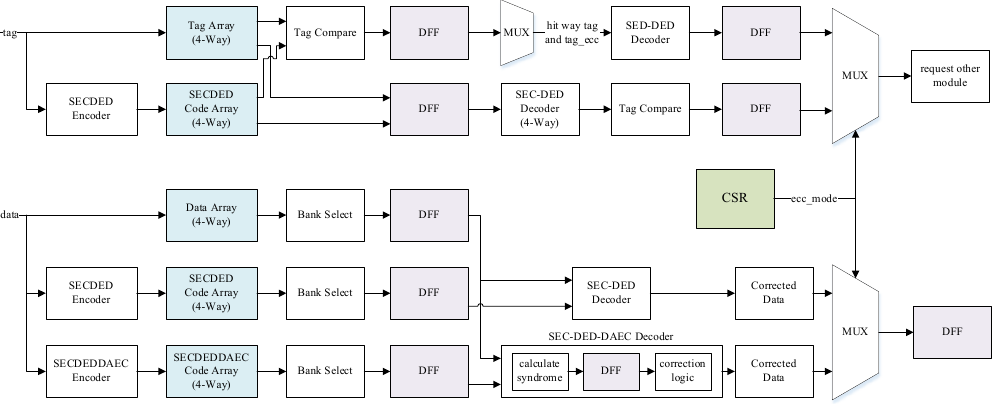
Figure 5. Flexible design scheme with ECC protection in cache.